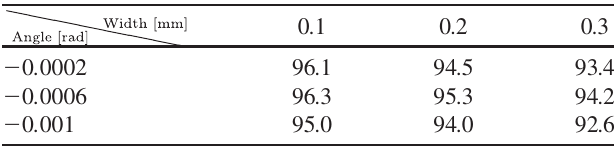
TABLE IV. Extraction efficiency measurements (%) simulated for different relative angles between beam and septum blade and different septum